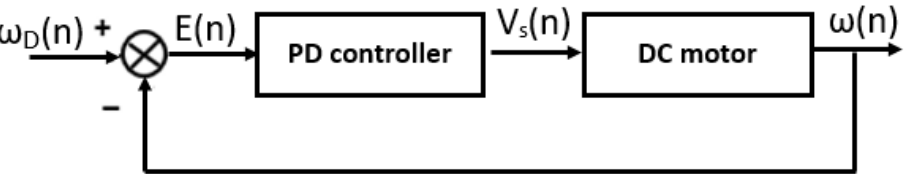
Figure 17. Closed-loop simulated system with a PD controller and with a negative and unitary feedback